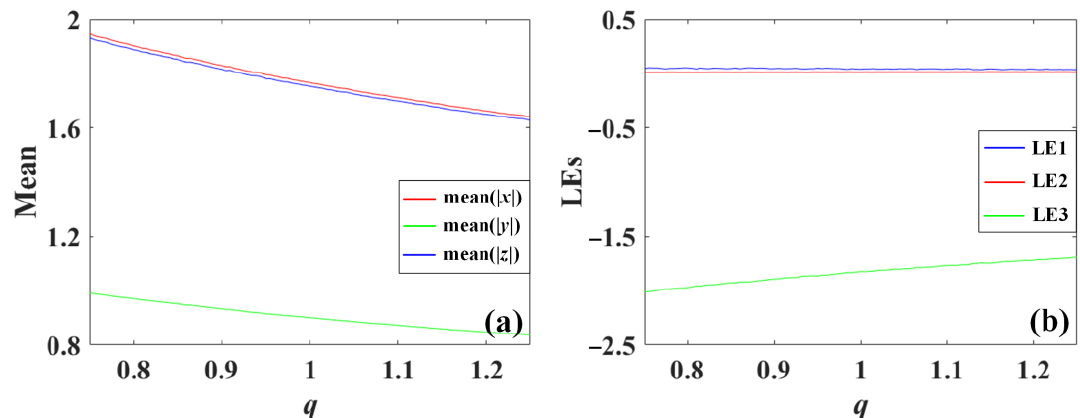
Figure 9. System (7) with a = 0.5, b = 0.6, c = 1.2 under initial condition (0, 1, 0) when m varies in [0.75, 1.25]: ( a ) average values, ( b ) Lyapunov exponents.